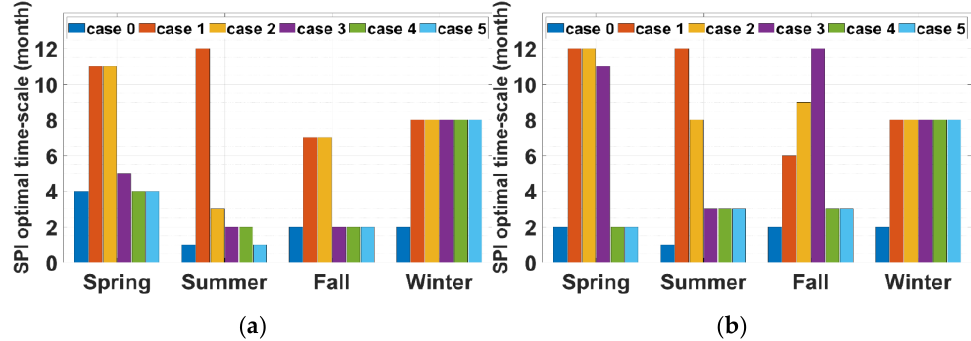
Figure 12. Optimal timescale for each case between SPI-m and SRI-1: ( a ) Andong Dam Basin; ( b ) Hapcheon Dam Basin. ( b ) Hapcheon Dam Basin.